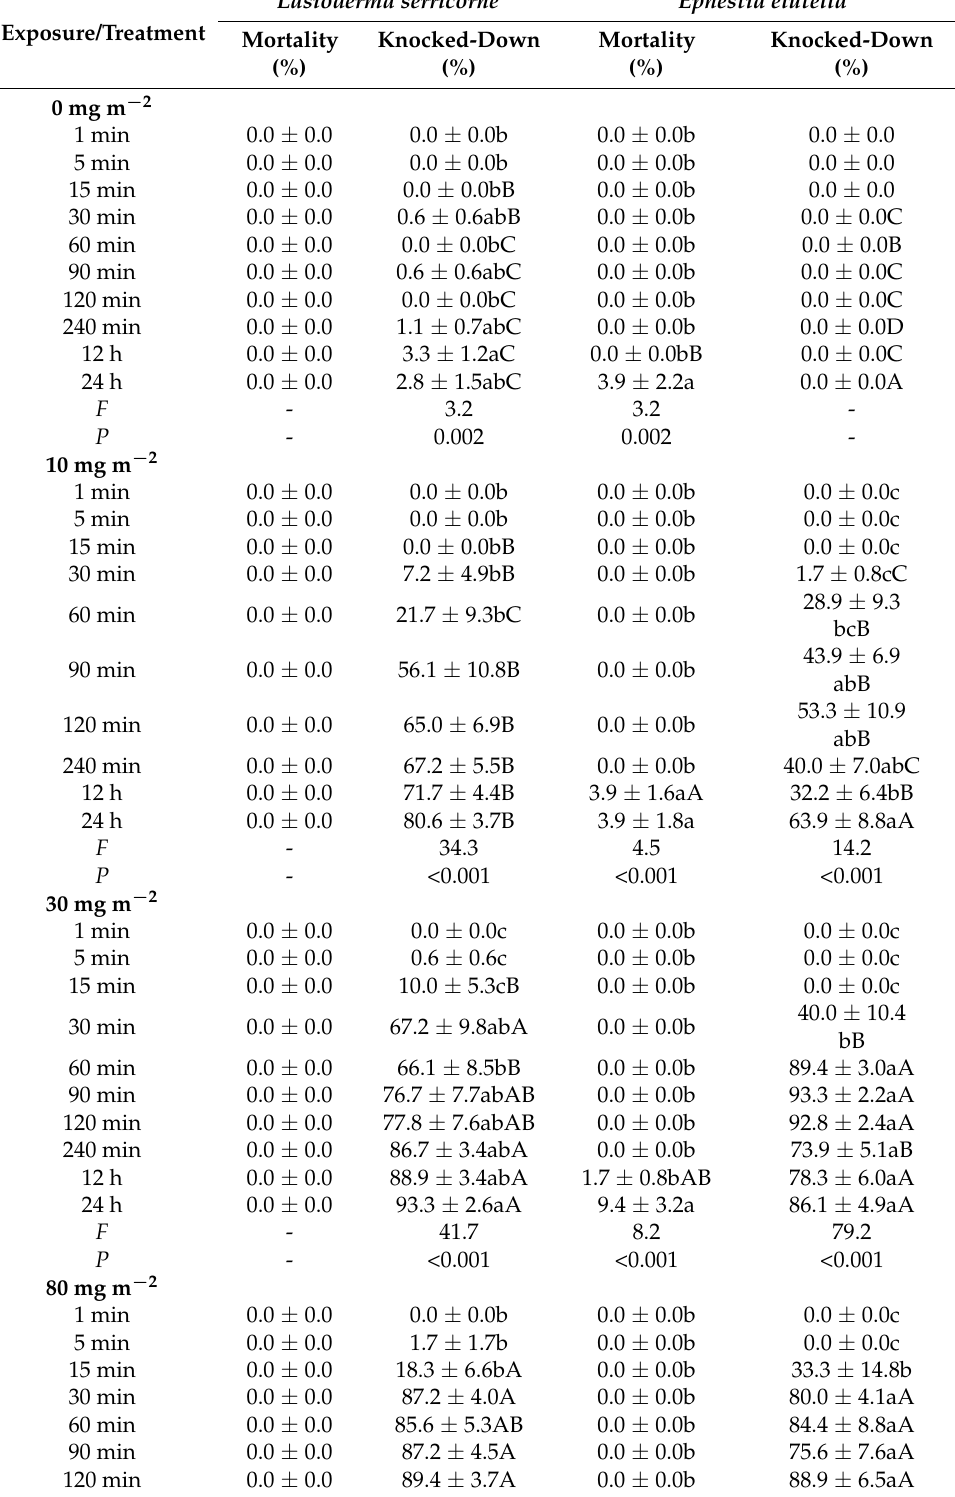
Table 1. Mean mortality and knock-down effect (% ± SE) of Lasioderma serricorne and Ephestia elutella adults exposed for 1, 5, 15, 30, 60, 90, 120, and 240 min and 12 and 24 h to nets with different concentrations of alpha-cypermethrin (0, 10, 30, 80, 163.5, and 325 mg m − 2 ), evaluated